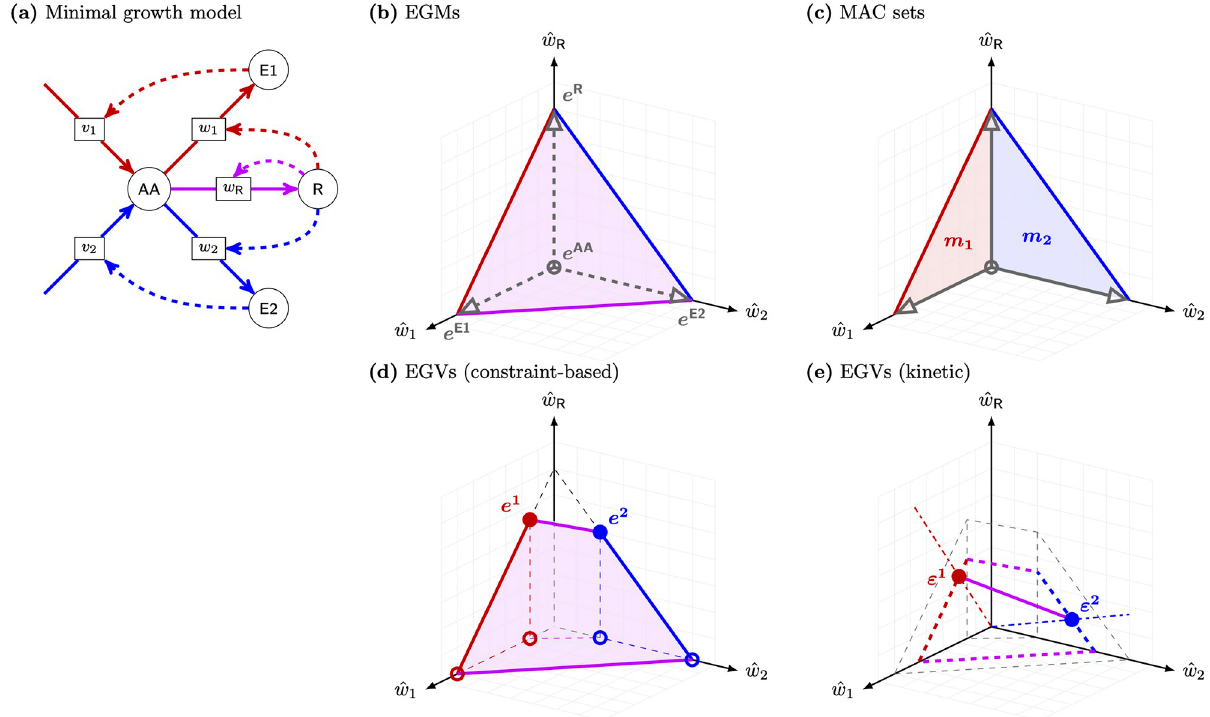
Fig 9. Comparison of EGMs, MAC sets, and EGVs. (a) The minimal growth model with alternative pathways is given by 4 molecular species { AA , E1 , E2 , R } (circles) and 5 reactions (rectangles) labeled by the corresponding fluxes v = ( v 1 , v 2 ; w 1 , w 2 , w R ) T . The “enzymes” E1 , E2 catalyze the formation of amino acids AA , and the ribosome R catalyzes the synthesis of the enzymes and the ribosome itself. (b) After scaling ( ^ v ¼ v = m ) and projection to the (scaled) synthesis fluxes ð ^ w ; ^ w ; ^ w Þ T , the growth cone becomes a growth polytope (a 3-dimensional simplex), generated by the (scaled and projected) 1 2 R EGMs e AA , e E1 , e E2 , and e R . Every EGM produces exactly one species as indicated by its name. (c) After projection, the MAC subsets of reactions are m 1 = { w 1 , w R } and m 2 = { w 2 , w R } (indicated by the corresponding fluxes). MAC sets represent minimal pathways: GMs with support m 1 (in red) lie in the two-dimensional simplex generated by the EGMs e AA , e E1 , and e R . Analogously for GMs with support m 2 (in blue). EGMs (in gray), lying on the axes, are not AC. (d) Enzyme capacity imposes additional inequality constraints, and the growth polytope gets restricted (depending on growth rate and k cat values). Here, the growth polytope is generated by 6 (scaled and projected) EGVs. Thereby, only EGVs e 1 and e 2 have nonzero ribosome flux and hence are AC. (e) Alternatively, in (semi-)kinetic models, enzyme kinetics imposes additional equality constraints, and the growth polytope gets restricted (depending on growth rate and metabolite concentrations). Here, the growth polytope is generated by the (scaled and projected) EGVs ε 1 and ε 2 (and hence is 1-dimensional). The EGVs have nonzero ribosome flux and hence are AC. For a complete mathematical analysis of the minimal growth model, see Section D in S1 Text. An interactive version of panel (e) is available online at